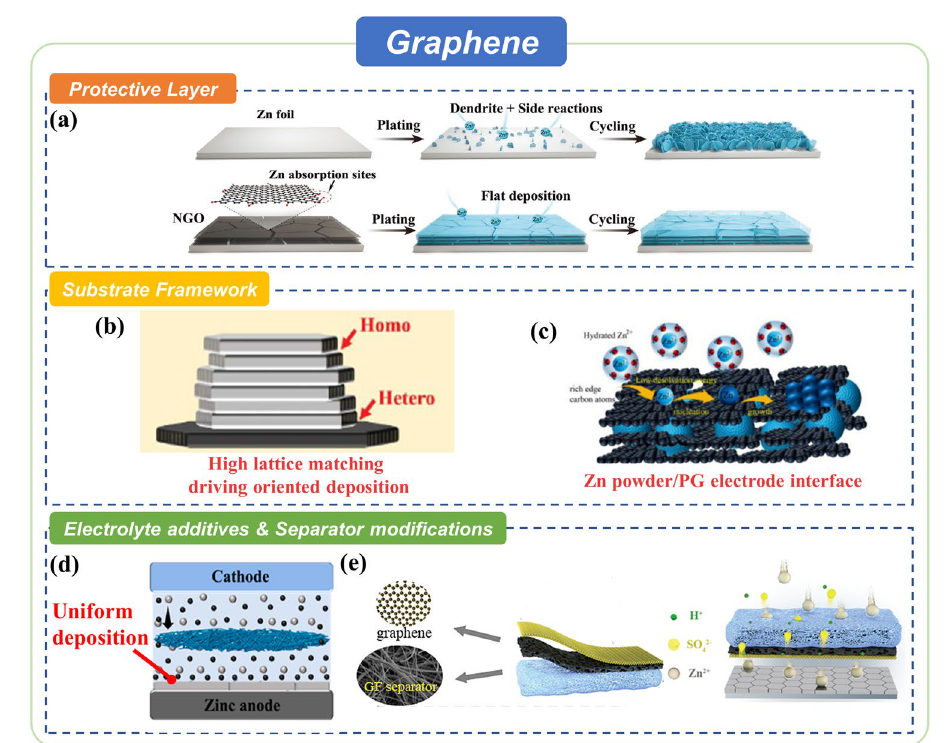
Fig. 4 Summary of graphene strategies for advanced Zn anodes. a Ultrathin surface coating of NDG. Copyright 2021, Wiley. b Confirmation of the relationship between Zn deposition and crystallographic orientation through graphene materials. Copyright 2019, American Association for the Advancement of Science. c 3D pristine graphene network combined with Zn powder. Copyright 2022, Elsevier. d GO electrolyte additive. Copyright 2021, American Chemical Society. e A functional separator constructed via parallelly grown graphene sheets. Copyright 2022,